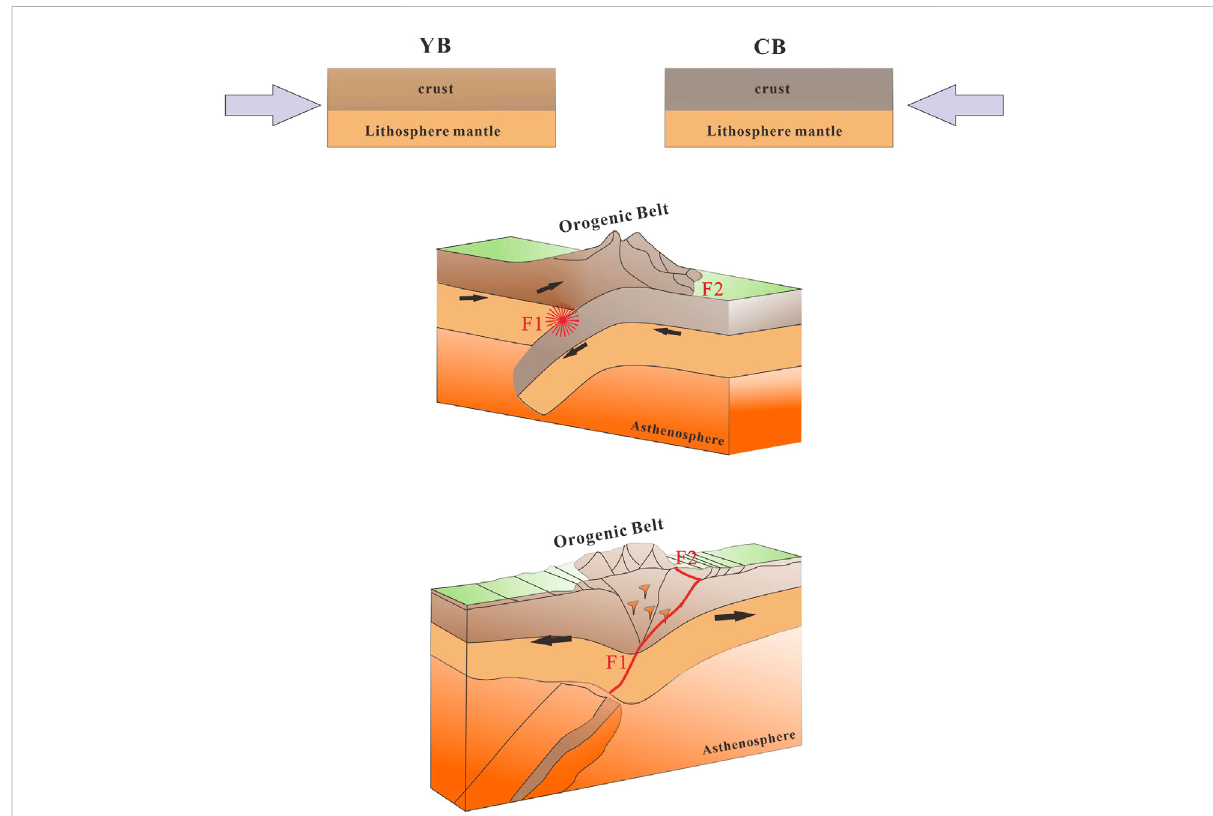
FIGURE 10 Subduction and amalgamation processes of suture zone between the YB and CB. This model describes the process of amalgamation between theYBandCBsincetheNeoproterozoic.TheCBsubductednorthwest-wardtowardthesoutheasternmarginoftheYB,andthenunderwentvarious geological processes, forming the current tectonic framework. Labels are the same as in Figure